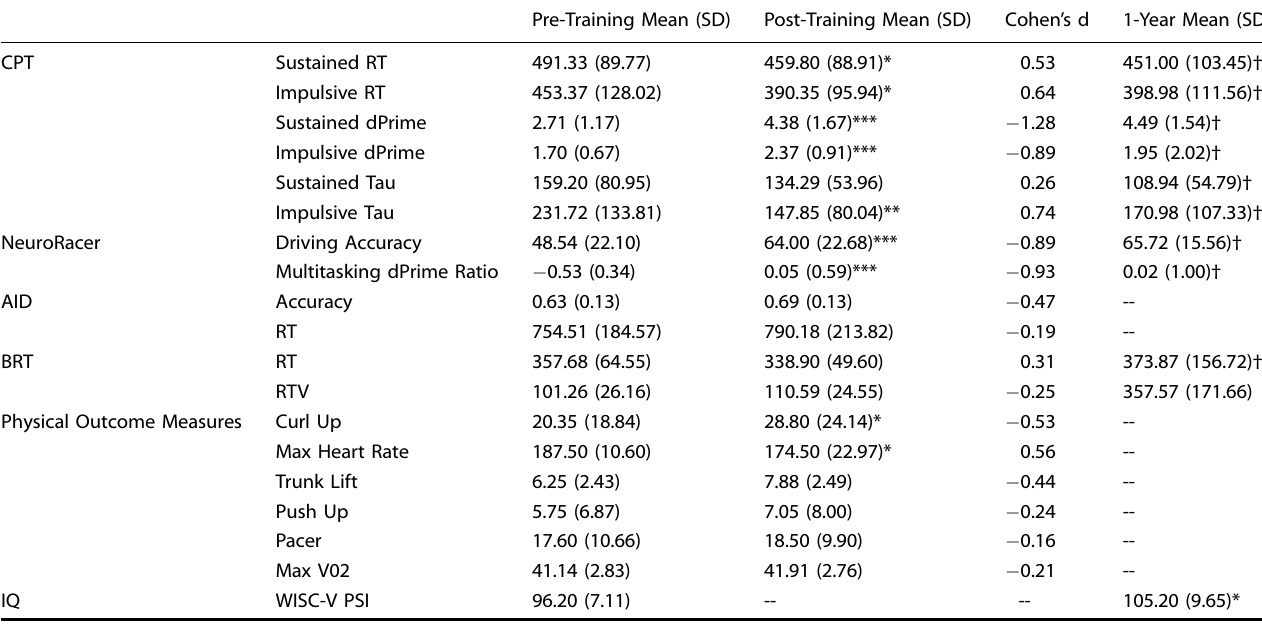
Table 2. Secondary and Exploratory Outcome